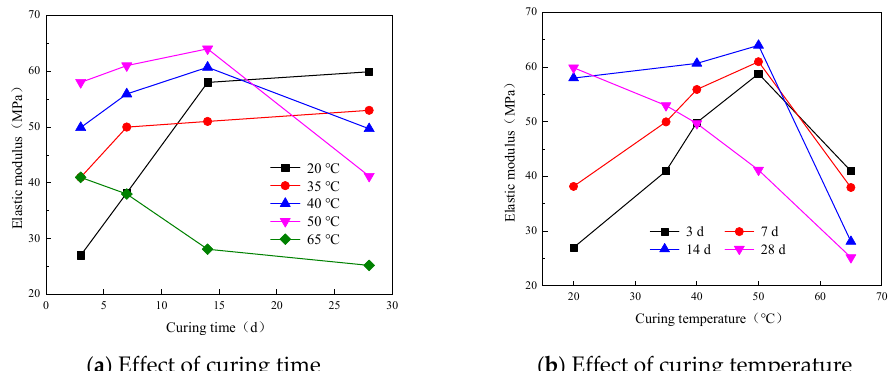
Figure 17. Variation law of elastic modulus with different factors.